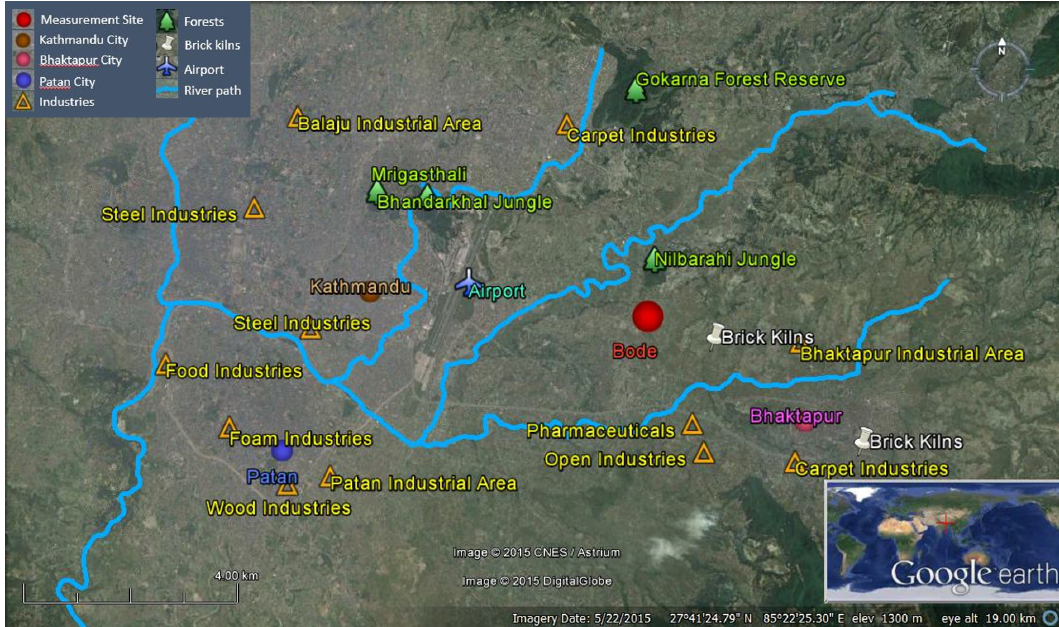
Figure 1. Location of the measurement site (Bode, red circle) along with surrounding cities (Kathmandu, brown circle; Patan, blue circle; Bhaktapur, pink circle), brick kilns (white markers), major industries (yellow triangles), forest areas (green tree symbols), airport (blue marker) and major river paths (sky blue) in the Google Earth image of the Kathmandu Valley (obtained on 22 May 2015 at